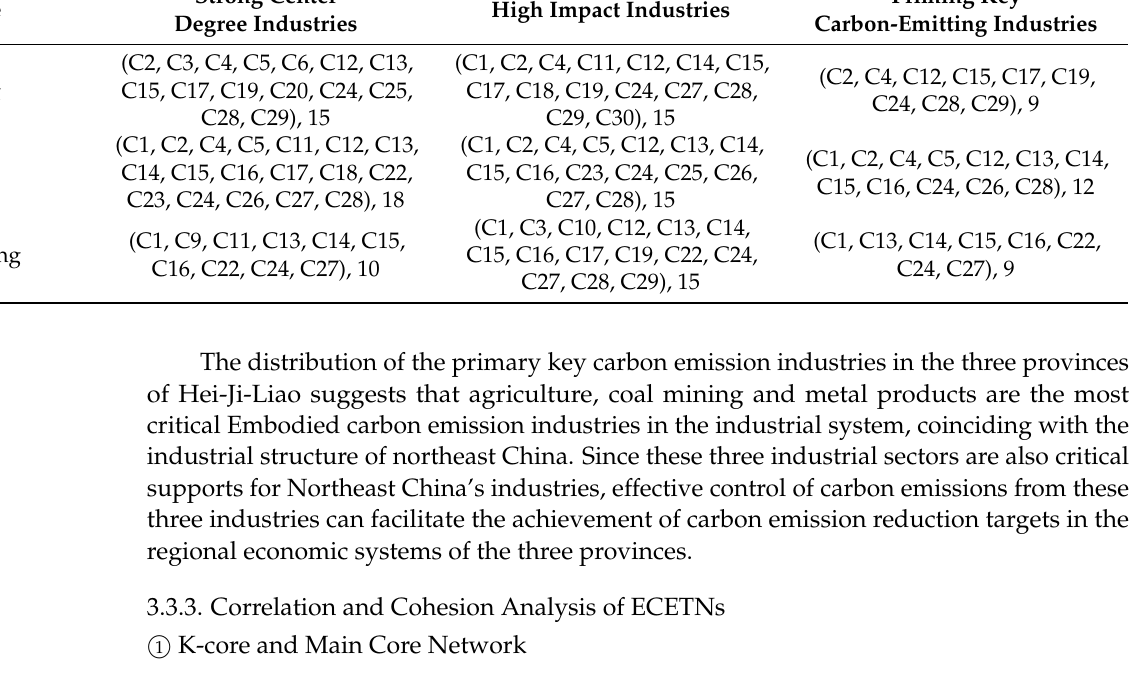
Table 7. Primary selection of key carbon-emitting industry sectors in Hei-Ji-Liao.